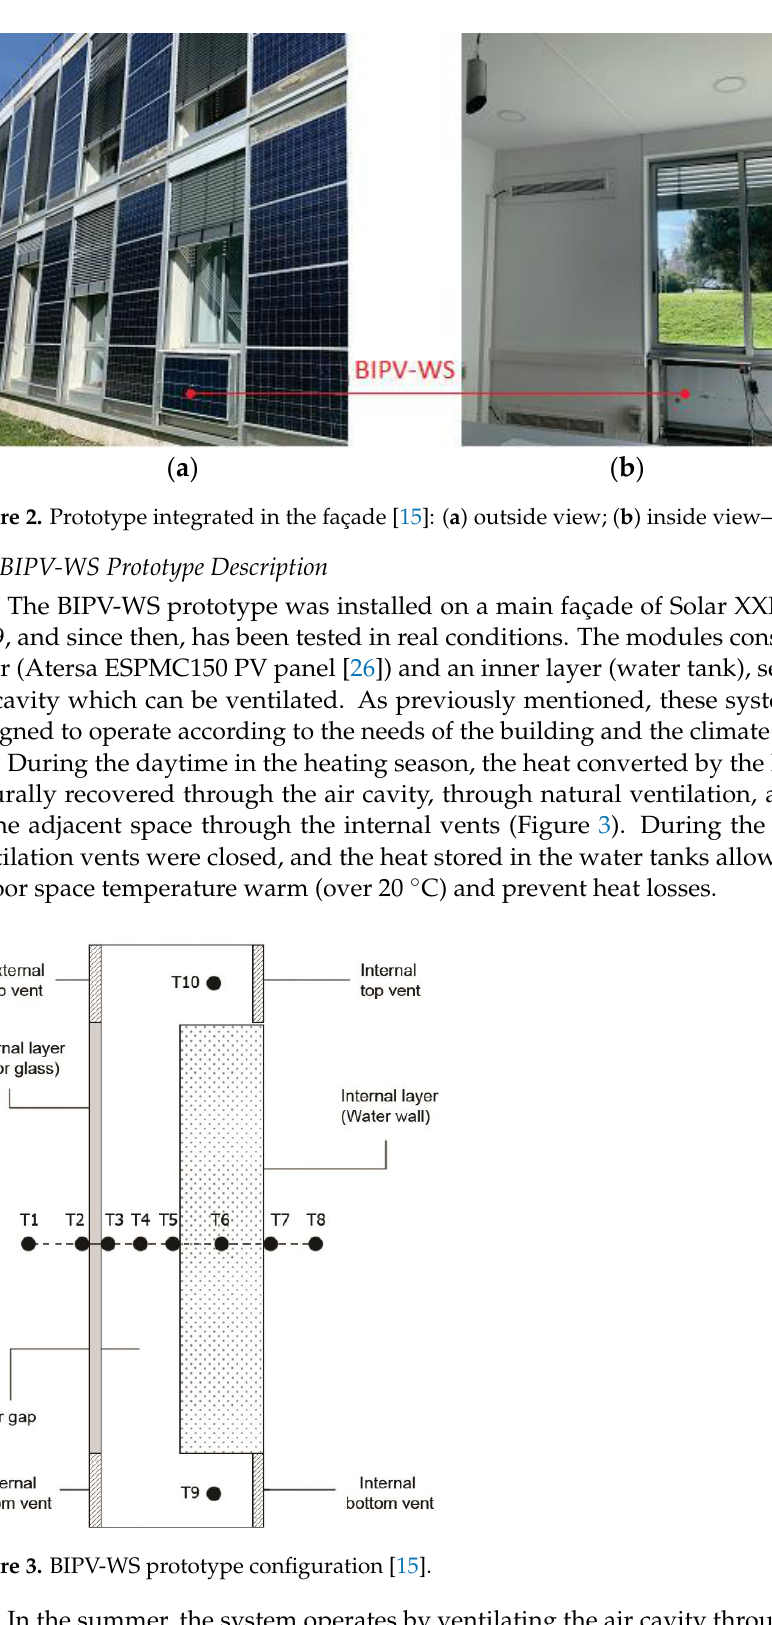
Figure 3. BIPV-WS prototype configuration [15].